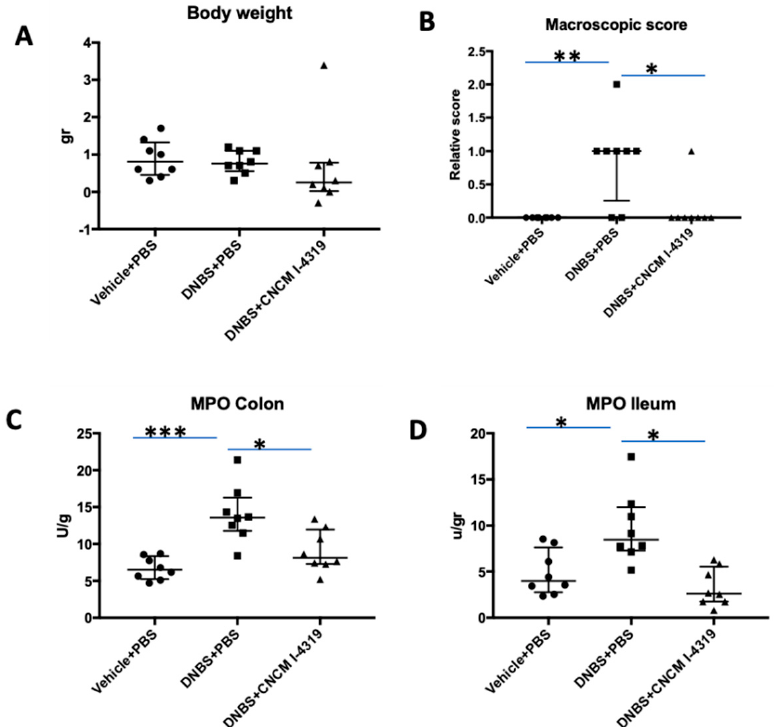
Figure 4. General health parameters in LGI model. Weight loss ( A ), macroscopic score ( B ), and colon and ileum MPO activity ( C , D ). Control non-inflamed (vehicle-PBS), control inflamed (dinitrobenzene sulfonic acid (DNBS)-PBS), B. bifidum CNCM I-4319 strain (DNBS-CNCM-I4319). *: p < 0.05; **: p < 0.01; ***: p < 0.001.